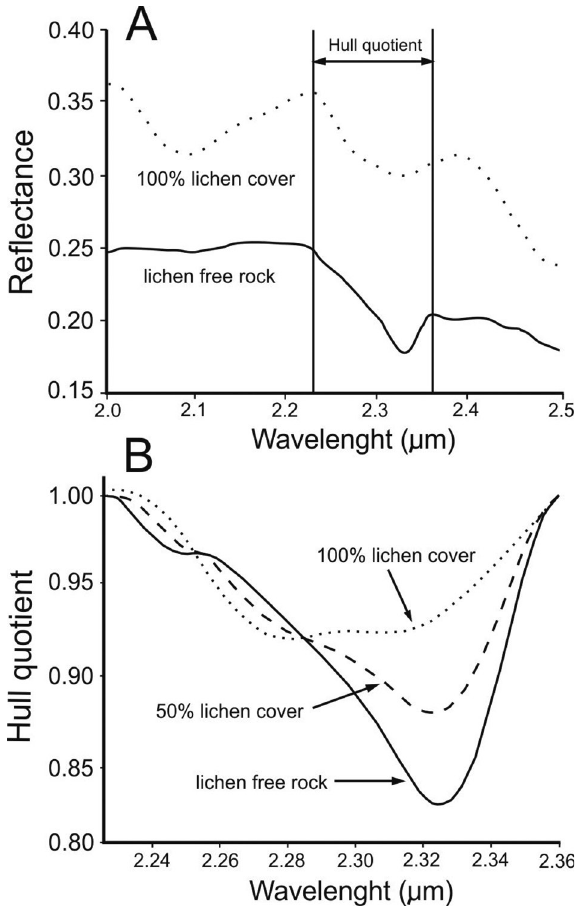
Fig. 2. A – Averaged spectra of kimberlite rock with and without crustose lichen cover, B – The corresponding hull quotient (clark, Roush 1984) with spectra associated with the antigorite absorption feature (acc. to Salehi et al. 2017,